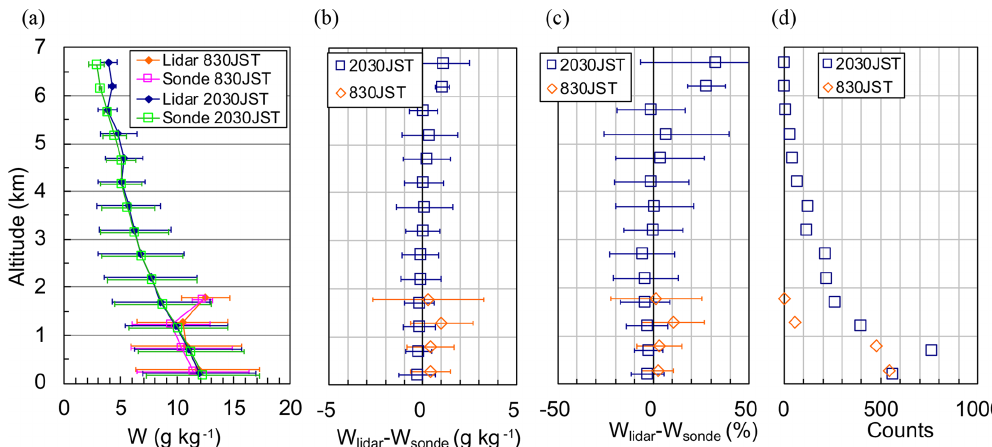
Figure 10. Vertical variations in (a) mean w Lidar values (diamonds) and w Sonde (open squares) values at intervals of 500m for 20:30 and 08:30LST from 2 August to 6 December 2016, and their (b) absolute and (c) relative differences. Symbols and error bars in (a) – (c) show means and standard deviations. (d) The number of data points at each